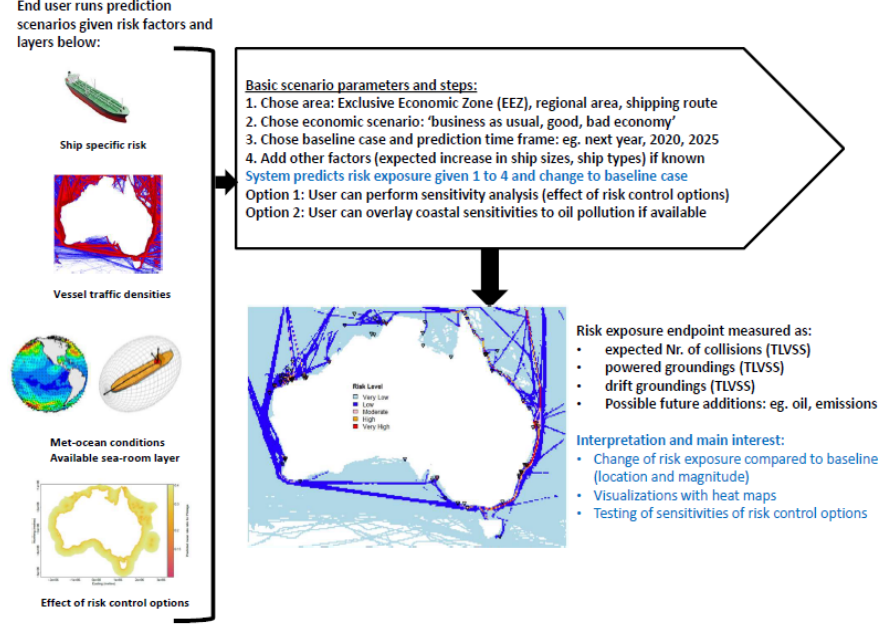
Figure 1. Generic end user application aspects of the strategic planning tool.